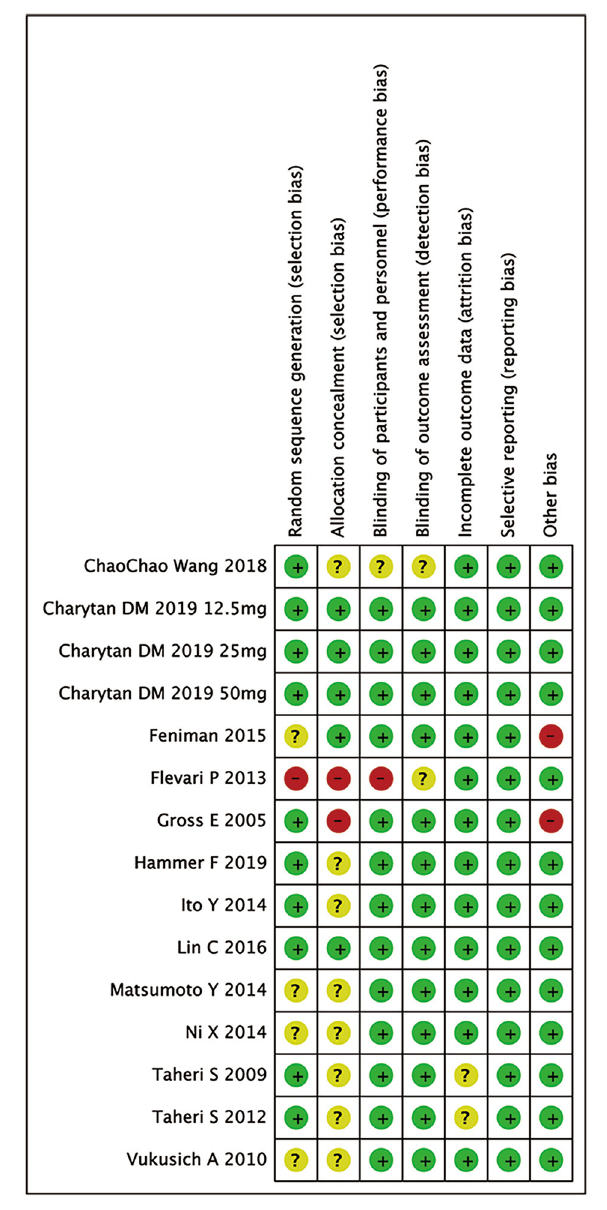
FIGURE 2 | Risk of bias in analyzed studies. Unclear risk of bias: “?”, low risk of bias: “-”, and high risk of bias: “ +